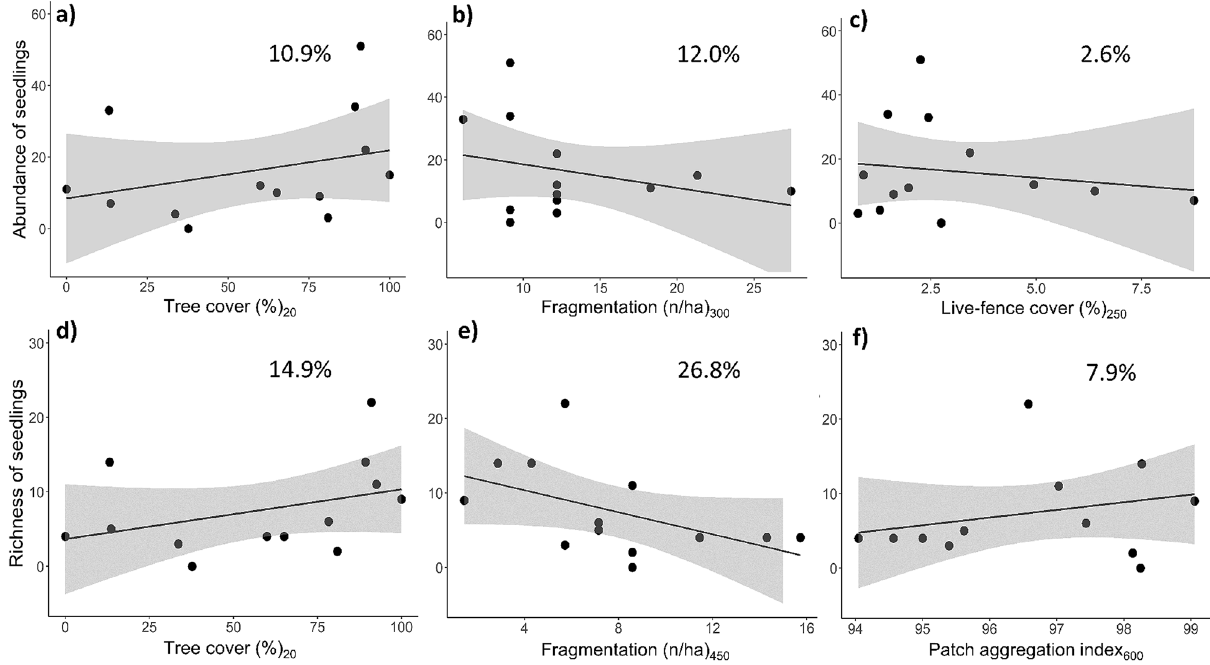
Figure 4. Univariate relationships between the landscape metrics and the abundance and species richness of late-successional seedlings in restoration plots in southern Costa Rica. The subscript indicates the scale of effect or landscape radius (m). The black line shows the predicted estimates from the regressions using a generalized linear model. The gray area represents the 95% confidence interval. The percentage of explained deviance (pseudo-R 2 ) is shown at the top of the panels. Black points indicate the restoration plots (n =